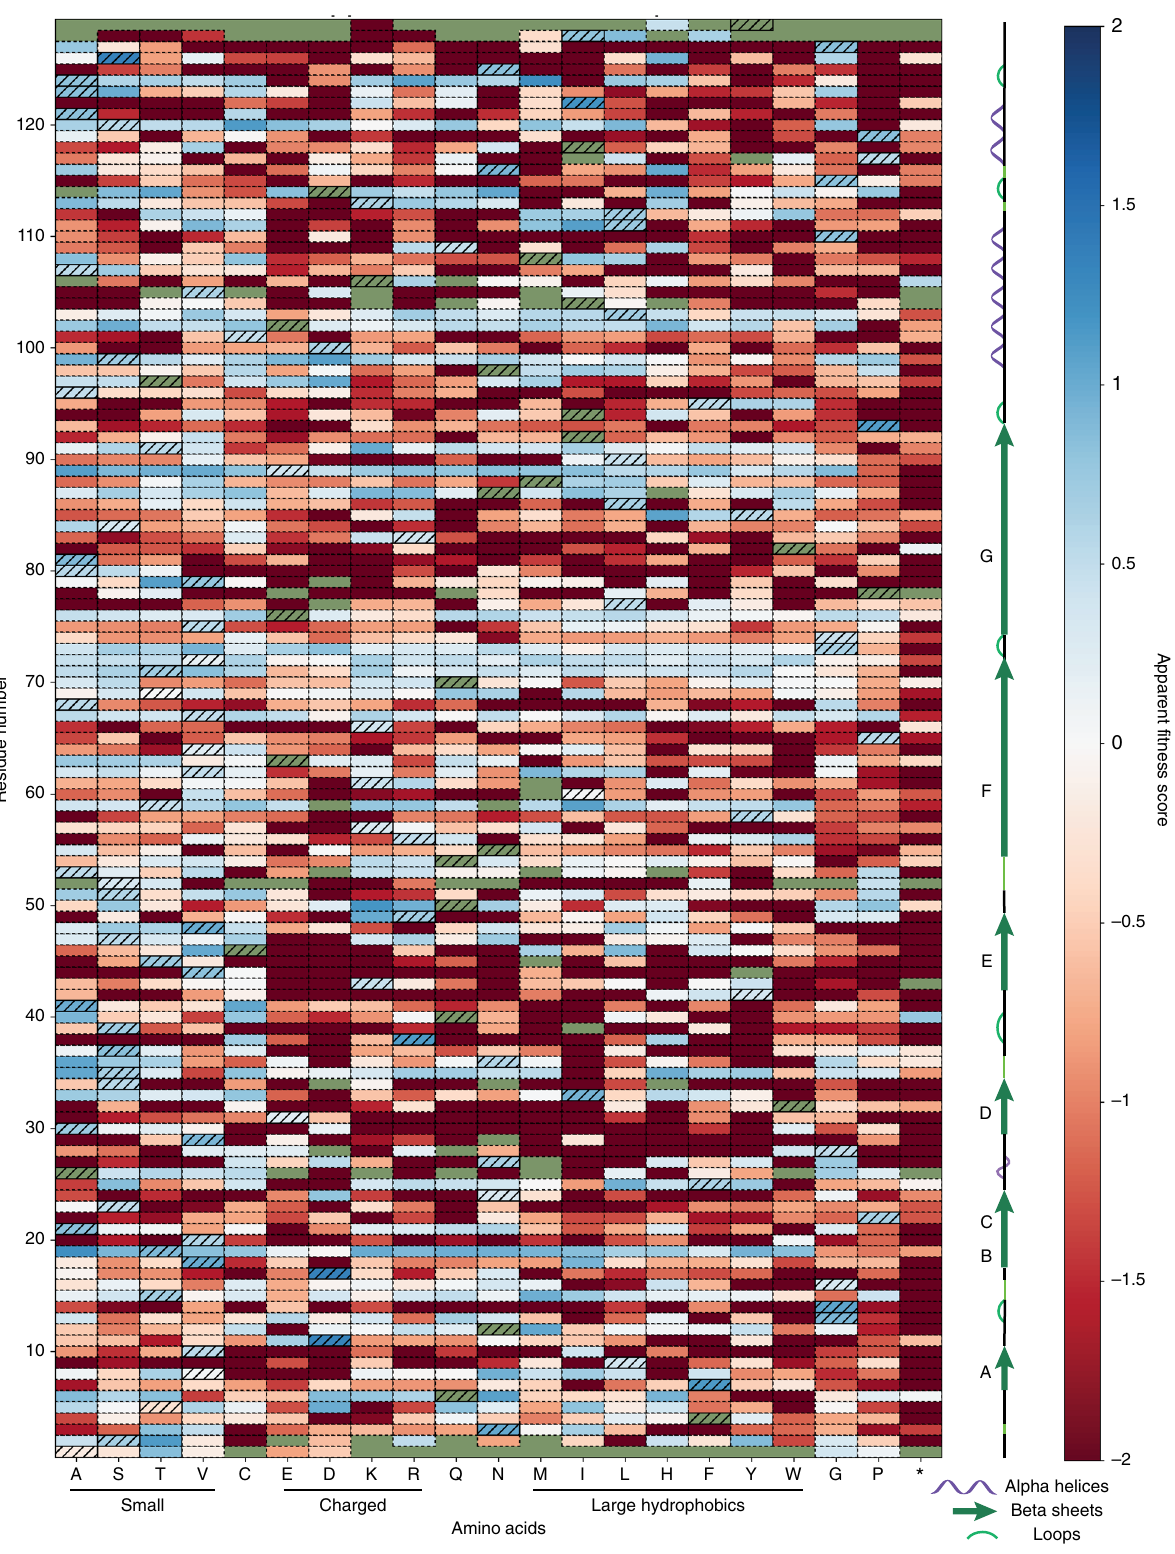
Fig. 2 Apparent fi tness scores (AFS, n = 3) for all single amino acid variants of the MS2 coat protein (MS2 CP). Wild-type residues are indicated with hatches, and missing values are green. Dark red variants were sequenced before selection but absent following